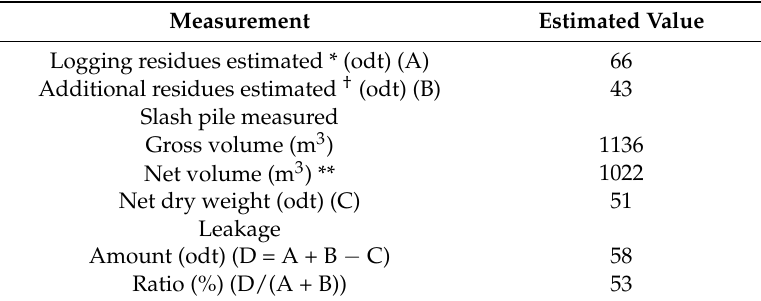
Table 8. Slash pile measurement and leakage estimation in the study harvest unit.